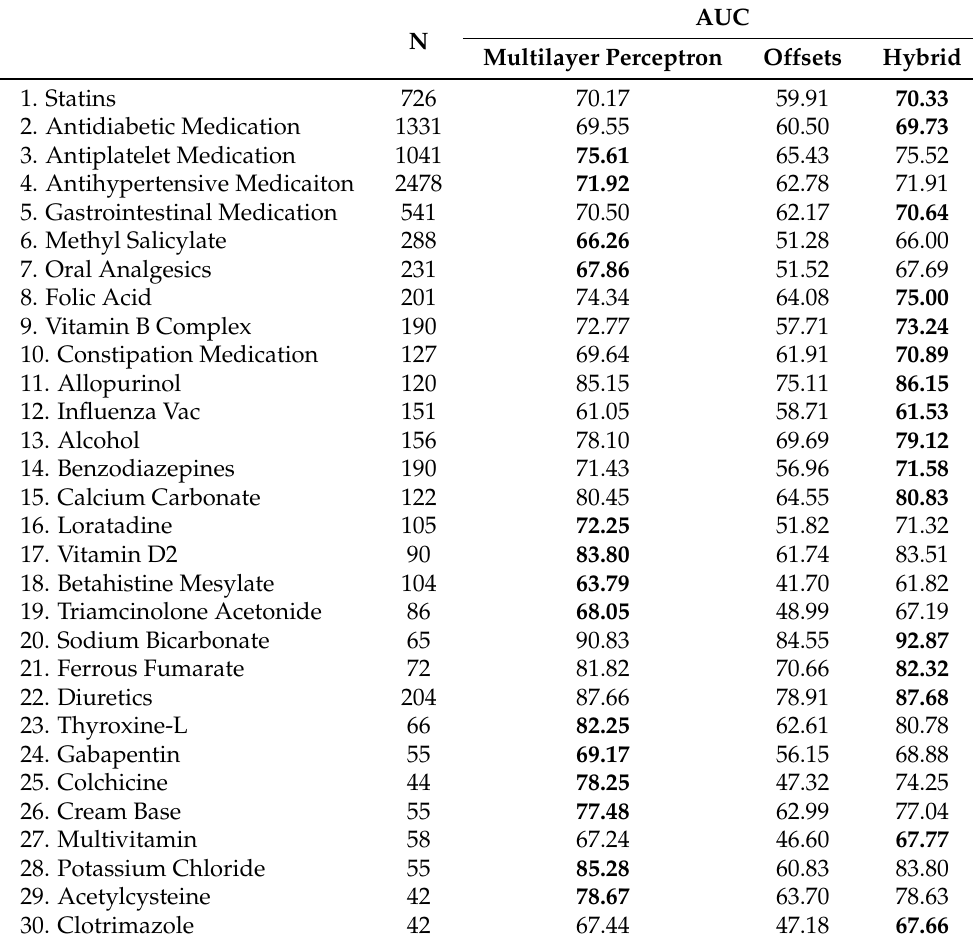
Table 3. Performance of the multilayer perceptron, Offsets, and hybrid models for recommending each drug in the test set.